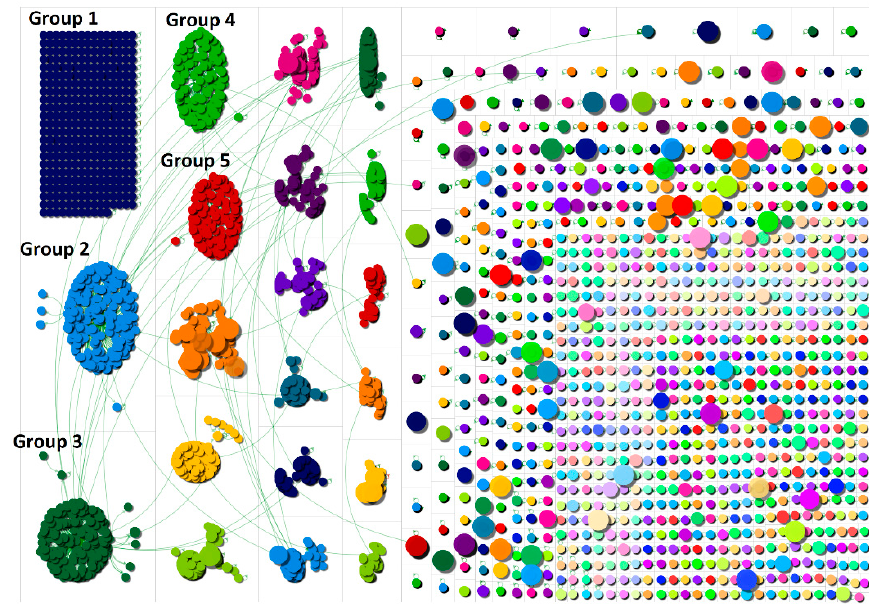
Figure 1. Network graph of masks from 27 June to 04 July.